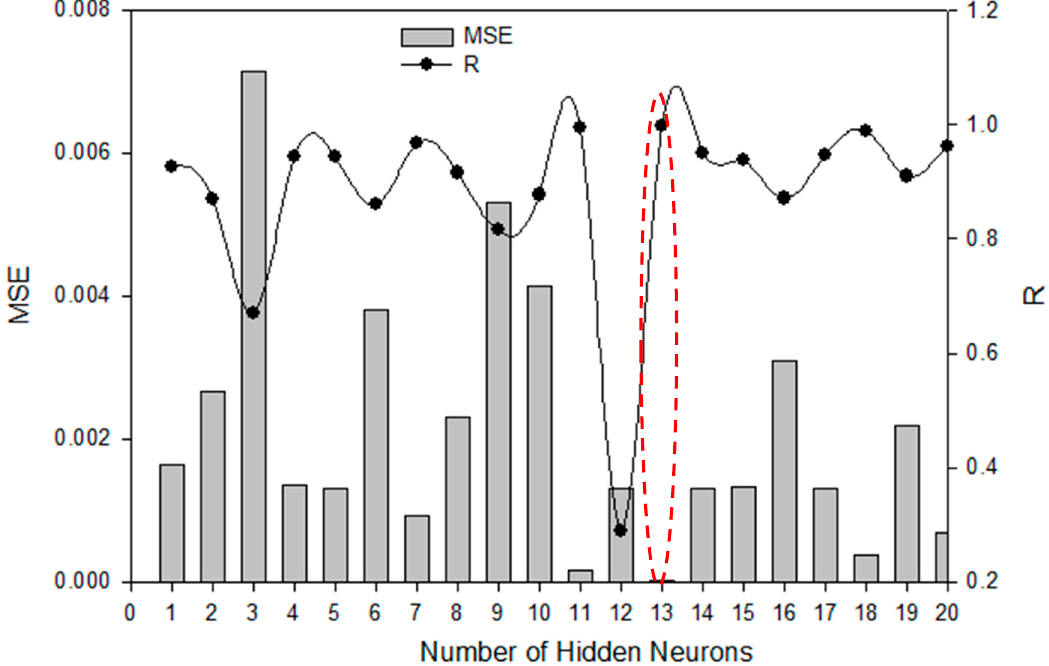
Figure 3. Determination of the optimized hidden neuron with the minimum mean square error (MSE) for ANN training using the Leven–Marquardt algorithm.